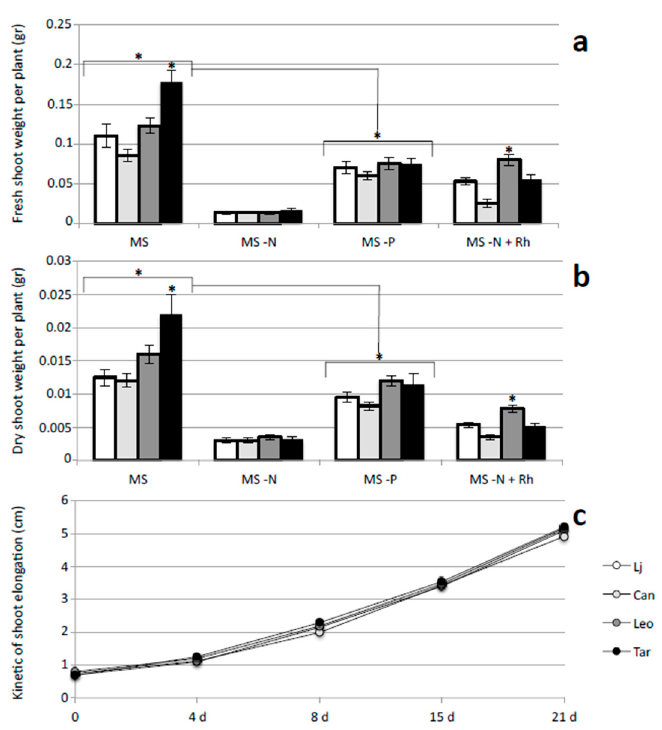
Figure 3. Quantitative analysis of shoot growth parameters of L. japonicus and L. corniculatus cvs Canetra, Leo and Targovishte 1, grown in the presence/absence of N and P sources in symbiotic and non symbiotic conditions. ( a ) Fresh shoot weight per plant; ( b ) Dry shoot weight per plant; ( c ) Kinetic of shoot elongation on MS complete medium. The different N and P regimes and when performed, M. loti inoculation is indicated. In panel ( c ) days after transfer on MS medium are indicated on the X axis; at 0 the sizes of seedlings at the moment of the transfer on MS plates are reported. White bars: L. japonicus . Light grey bars: L. corniculatus cv Canetra. Dark grey bars: L. corniculatus cv Leo. Black bars: L. corniculatus cv Targovishte 1. Data bars represent means and SD of measures from three experiments (10 plants per experiment per condition). Data are scored 25 days after sowing (21 days after transferring the plants from H 2 O agar). Asterisks over horizontal lines indicate significant differences for all plants tested in those conditions. Asterisks over single bars indicate significant differences for Targovishte 1 cv and Leo cv plants ( p < 0.05).